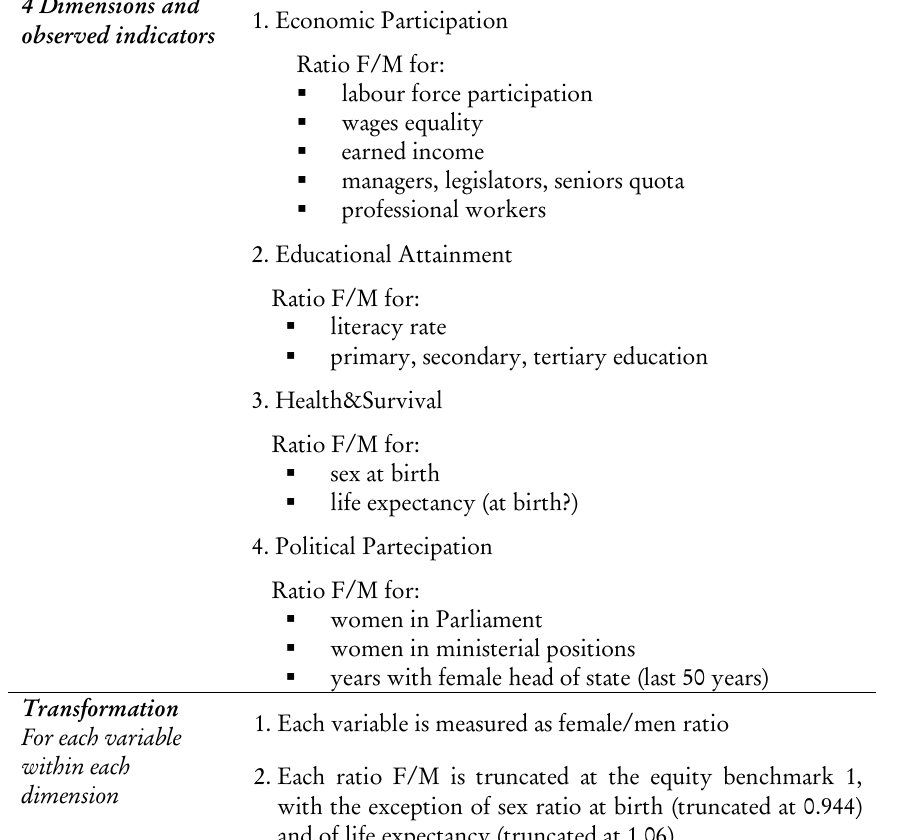
Features and methodology of GGGI